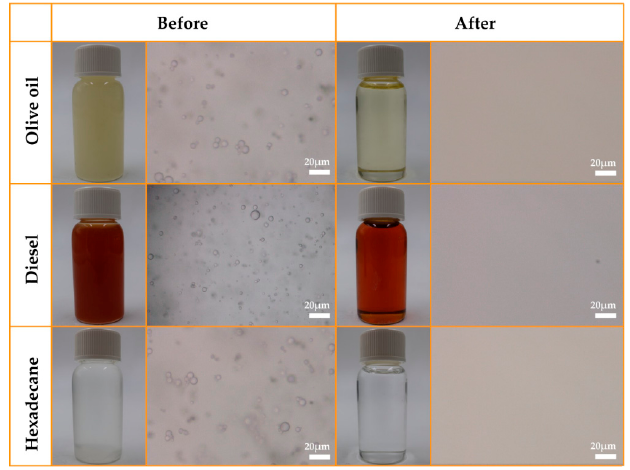
Figure 5. Photographs of stabilized water-in-olive oil emulsion, stabilized water-in-diesel emulsion, and stabilized water-in-hexadecane emulsion before and after separation using the treated cotton.